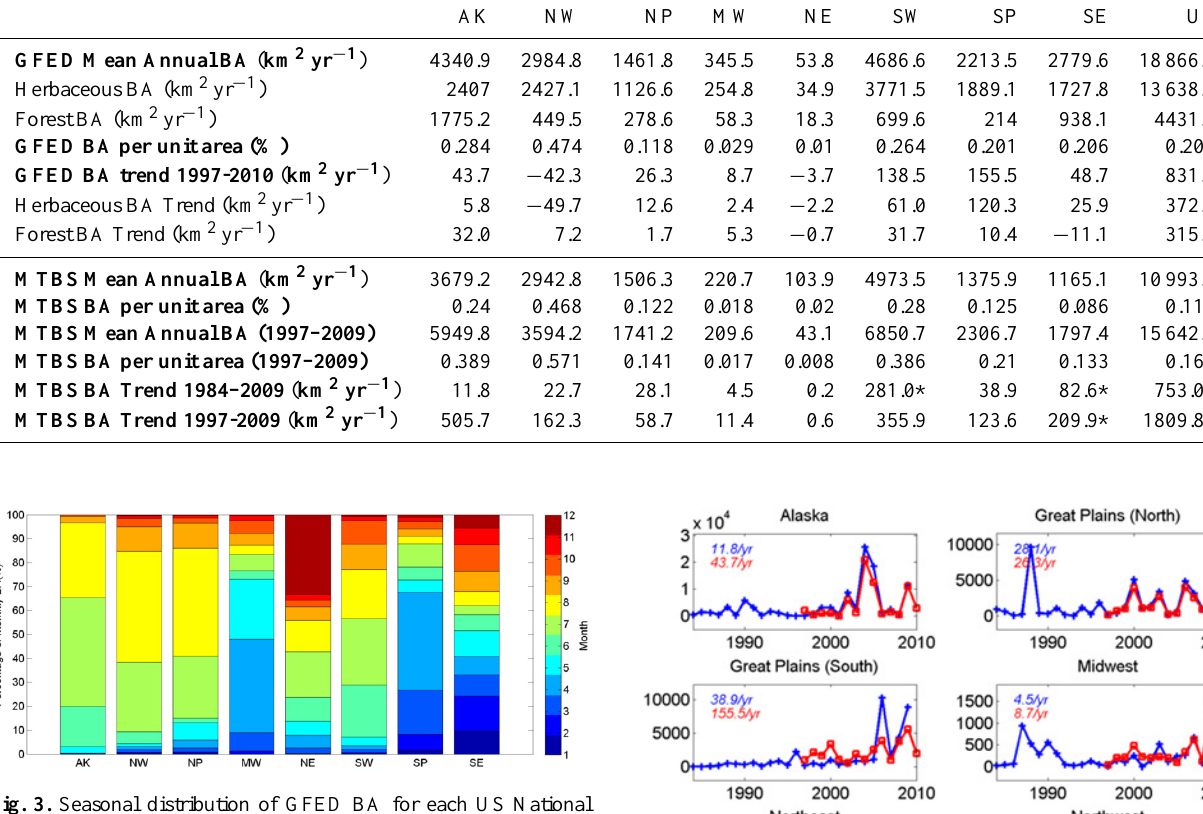
Fig. 3. Seasonal distribution of GFED BA for each US National Climate Assessment study region during 1997–2010.